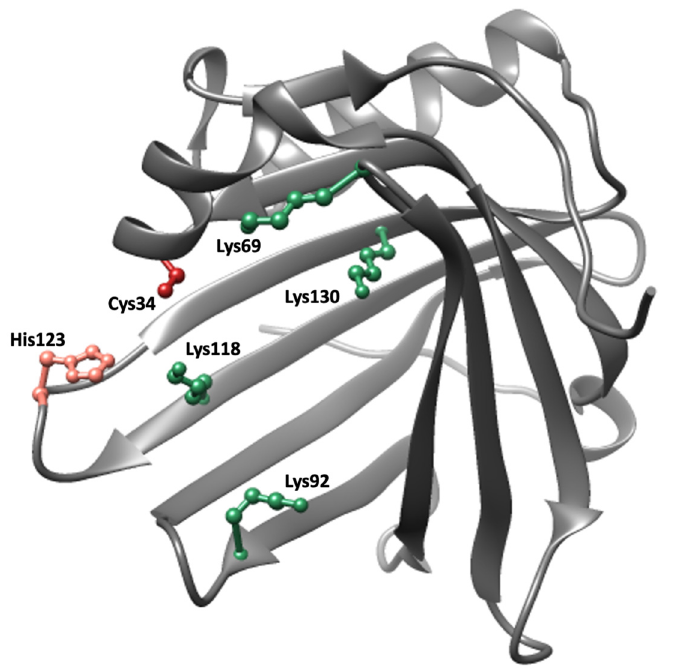
Figure 2. Crystal structure of A1M [87] . Important side chains involved in the protective properties of A1M are highlighted; Cys34 (red), His123 (pink) and Lys69, Lys92, Lys118 and Lys130 (green).